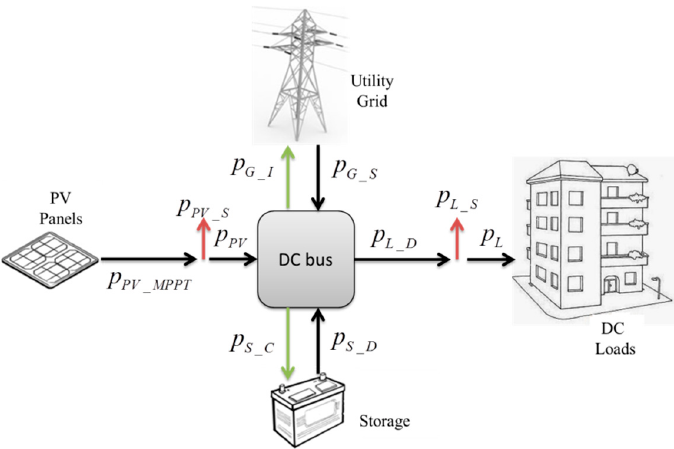
Figure 2. Proposed grid ‐ connected DC microgrid power flow exchange.